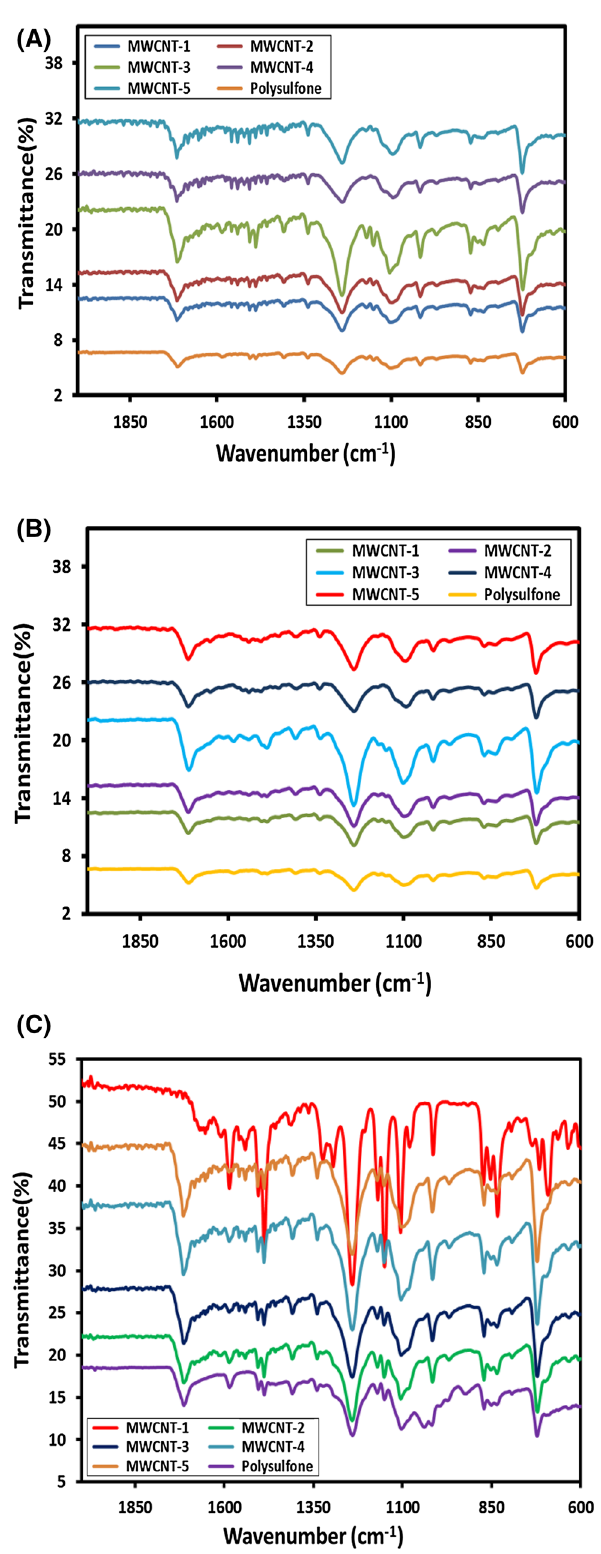
Fig. 5 ATR-FTIR spectra of TFC and modified membranes with a pristine-MWCNT in MPD, b pristine-MWCNT in TMC and c MWCNT–COOH in